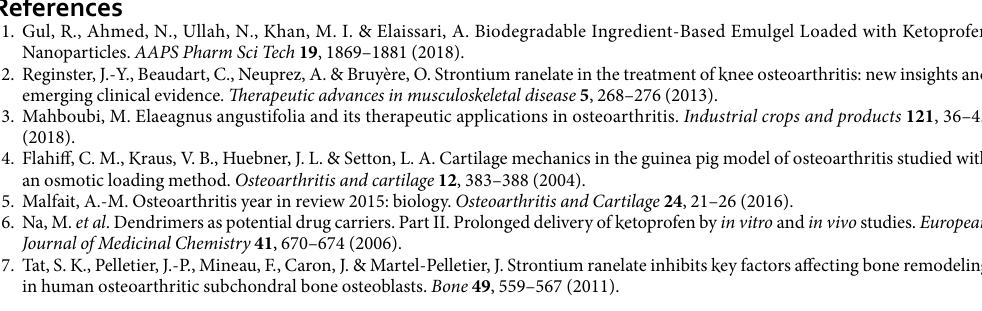
was taken out to calculate the drug release using by UV-Vis (at 260 nm) at different time point. Meanwhile, 5 mL of freshly preheated PBS solution was added to the mother liquor to keep the equilibrium of total solution. The amount of ketoprofen loading was determined with high performance liquid chromatography (HPLC) and TGA. And the release percentages of ketoprofen were calculated according to the formula, release percentage (%) = m r /m l , where m r is the amount of released ketoprofen, while m l is the total amount of loaded ketoprofen. In vitro cytotoxicity. PTA-MOF was evaluated by methyl thiazolyl tetrazolium (MTT) assays against chondrocyte. Briefly, chondrocyte was plated in a 96-well plate with a density of 1 × 10 4 cells/well, cultured for 24 h. Then, 100 μ L of Sr/PTA-MOF with various concentrations were added and incubated for 24 h. 10 μ L of MTT (5 mg/mL) were added and incu- bated for another 4 h after the cell medium was replaced and washed with PBS. Finally, the MTT-formazan gen- erated by live cells was dissolved in 100 μ L of dimethyl sulfoxide (DMSO), and the absorbance at 490 nm of each well was monitored using the iMark Microplate Reader. The cytotoxicity was estimated by the relative cell viability (%) compared with the untreated control cells.